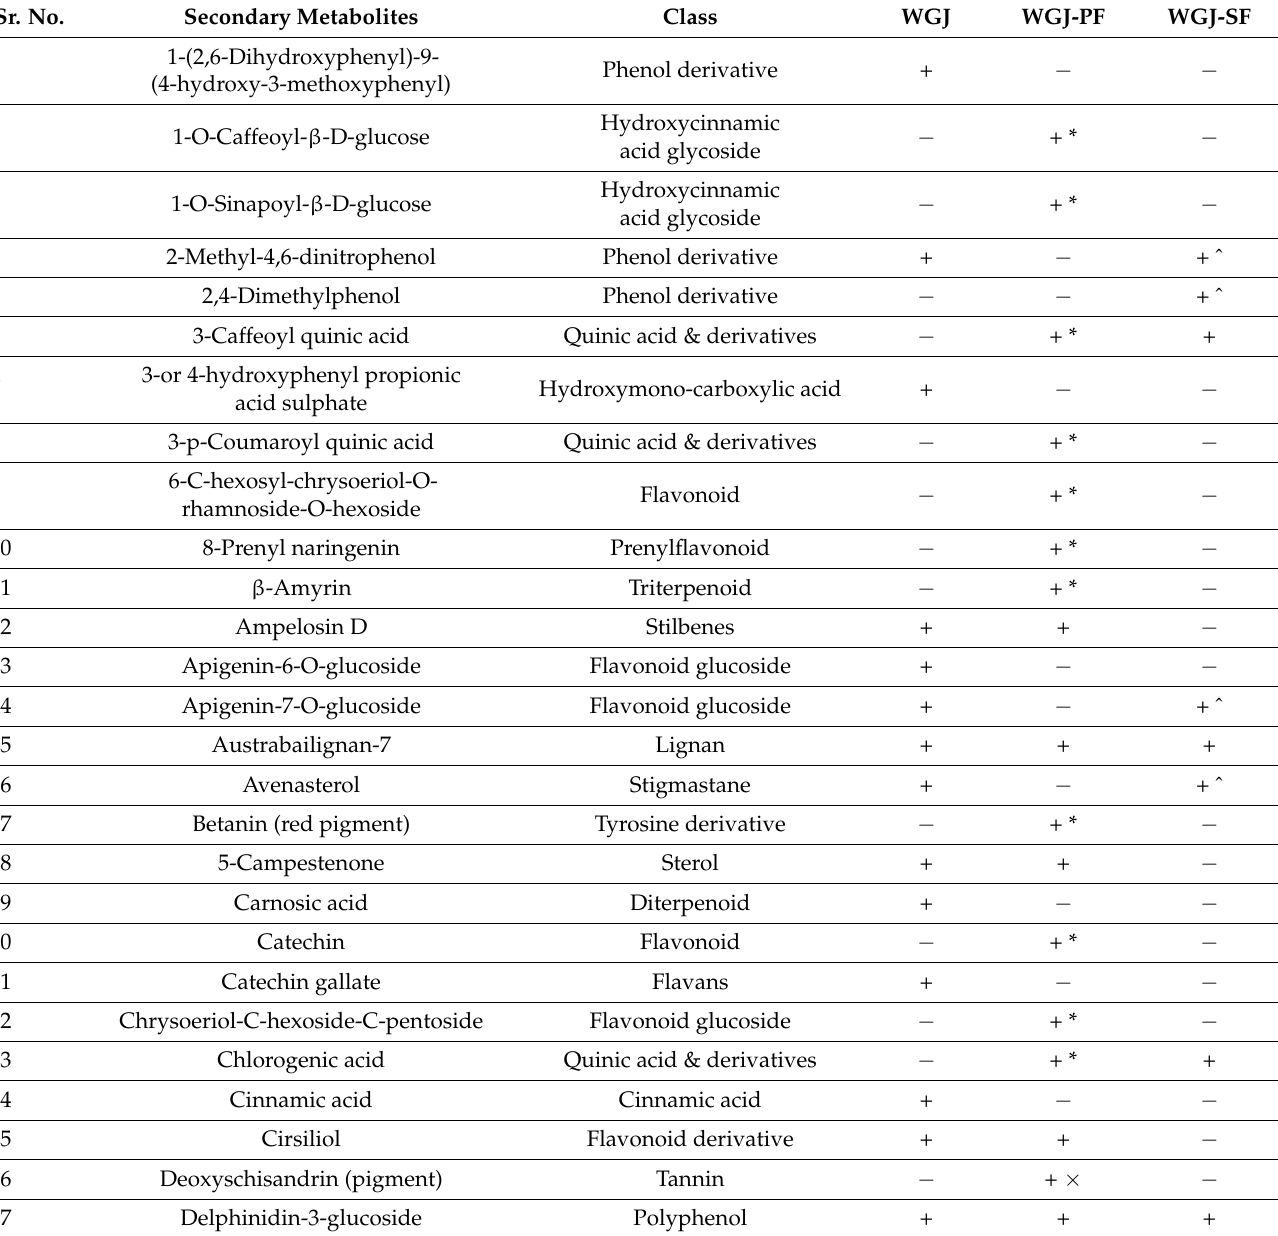
Table 2. Characteristics of secondary metabolites identified in fermented wheatgrass juice by LC-MS-